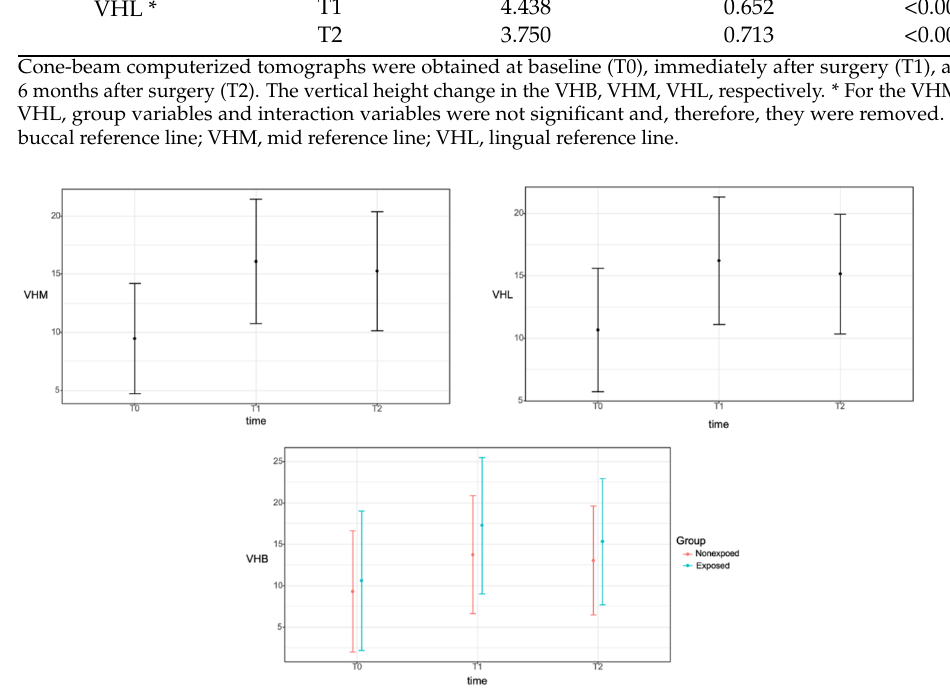
Figure 7. Correlation between the time (baseline, T0; immediately after surgery, T1; and at 6 months after surgery, T2) and the vertical height change in the VHB, VHM, and VHL reference lines using cone-beam computed tomography. The mean values are expressed as closed circles, and confidence intervals are represented by error bars. For the VHB, group, time, and interaction variables were included in the model because the interaction was significant. There was no significant difference in the VHB at T1 and T2 time points in the non-exposed group ( p = 0.371), but there was a significant difference between all other time points in the non-exposed and exposed groups ( p < 0.05). VHB, buccal reference line; VHM, mid reference line; VHL, lingual reference